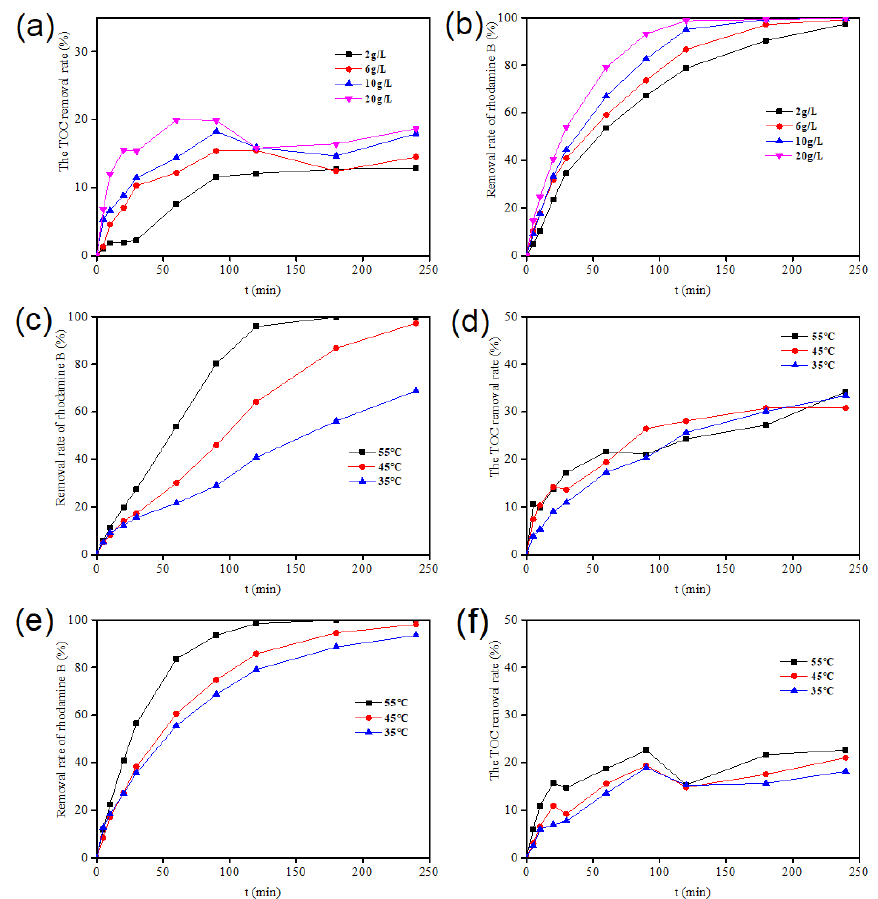
Figure 4. Effects of different reaction temperature( c , d ) ( 𝑐 0 = 200 mg/L, 𝑐 𝐻 = 196 mmol/L, pH = 3, catalyst = 10 g/L), ( e , f ) ( 𝑐 0 = 200 mg/L, 𝑐 𝐻 = 196 mmol/L, pH = 10,catalyst = 10 g/L); catalyst dosage ( a , b ) ( 𝑐 0 = 200 mg/L, 𝑐 𝐻 = 196 mmol/L, pH = 10, T = 55 °C) on the removal rate of rhodamine B.